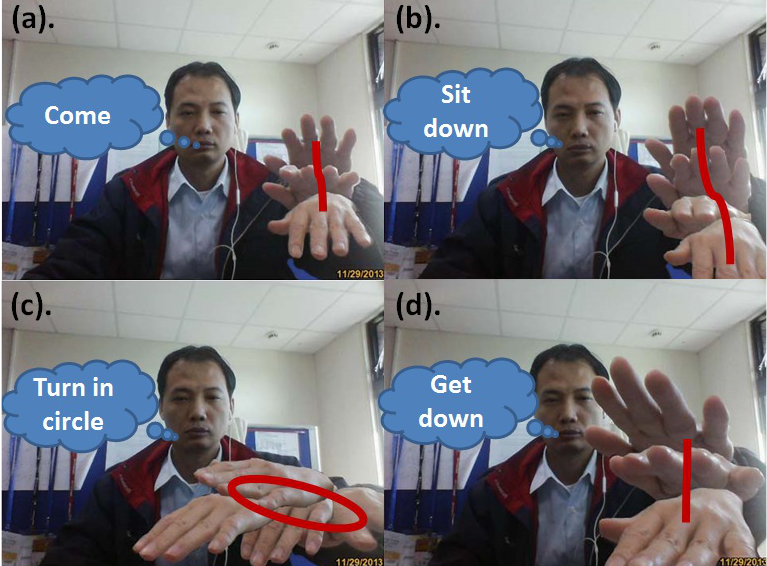
Figure 4. Hand gesture and speech training